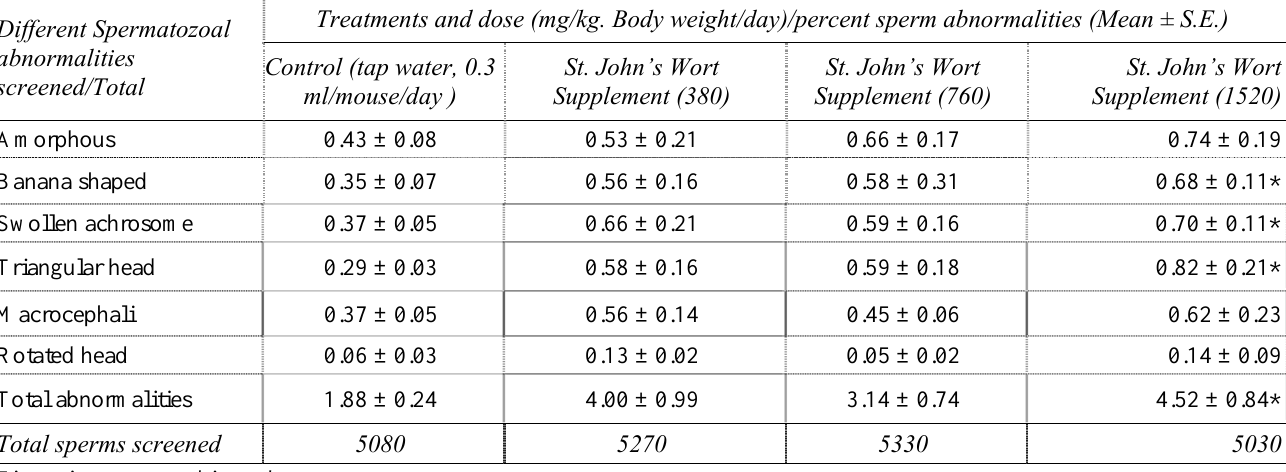
Table 3: Effect of St. John’s Wort Supplement on epididymal spermatozoa in Swiss albino mice after sub-acute treatment Different Spermatozoal